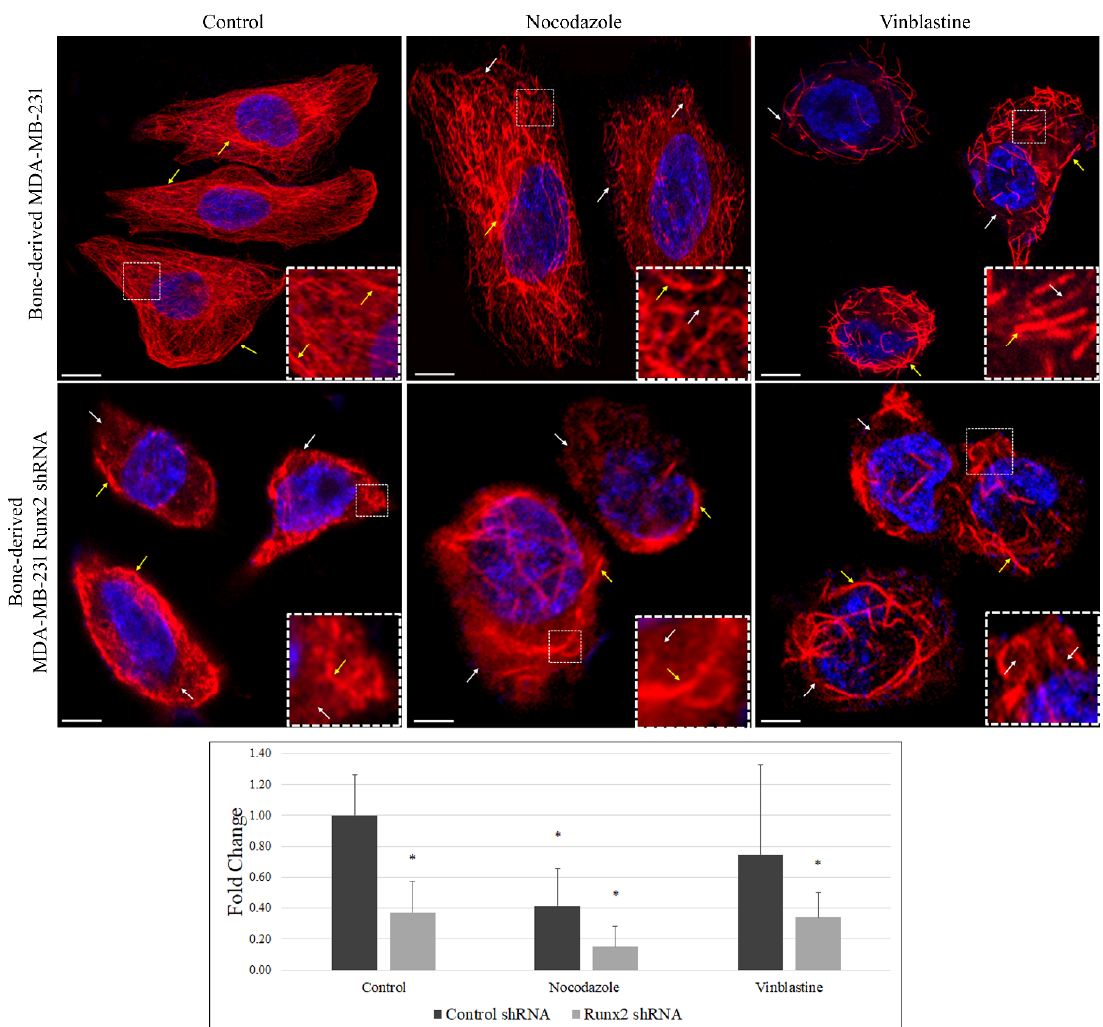
Figure 2. Loss of Runx2 sensitizes α-tubulin acetylation in response to MT-targeting agents. The bone-derived MDA-MB-231 control and Runx2 knockdown cells were treated with microtubule-targeting agents vinblastine (1 µM) and nocodazole (1 µM) for 5 min. The fixed cells were analyzed for acetyl-α-tubulin (Lys40) (Alexa fluor-594/Red) by immunofluorescence. Acetyl-α-tubulin (Lys40) is stained red, while nuclei are stained blue with DAPI. White arrows show loss of tubular structures and diffused staining. The yellow arrows show intact tubular structures. Cells ( n = 30) were quantified for tubulin signal intensity using ImageJ. Results were analyzed via an unpaired t -test (* p < 0.0001). The scale bar represents 50 µm. The data shown are representative of 3 independent experiments.